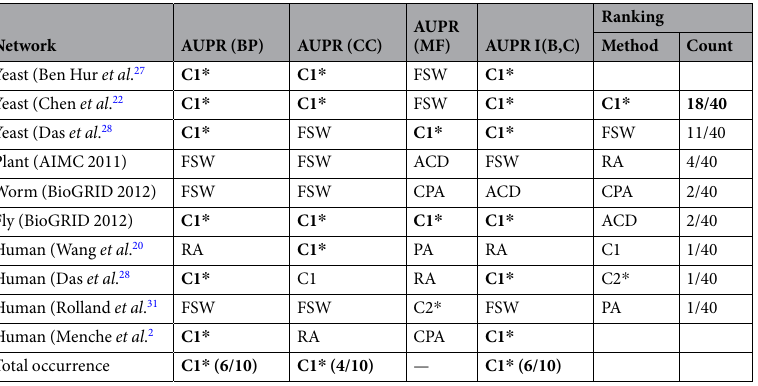
Table 1. Top method in each network according to AUPR performance measure considering different gene- ontology-based (GO-based) evaluations. From the left, the first column reports the name of the network considered. Second to fifth columns report the best method according to the following GO-based evaluations: biological process (BP), cellular component (CC), molecular function (MF) and the new strategy I propose that is the intersection of BP and CC, therefore it is indicated with I(B,C). On the right part of the table, it is reported the ranking of the methods. This ranking is obtained by counting for each method the number of times it arrives first across all the four different evaluations considering all the